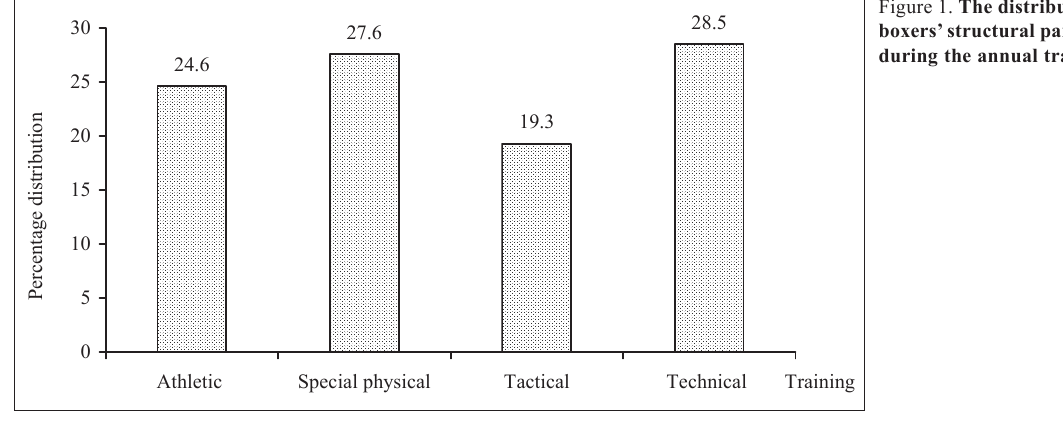
Figure 1. The distribution of young boxers’ structural parts of training during the annual training cycle